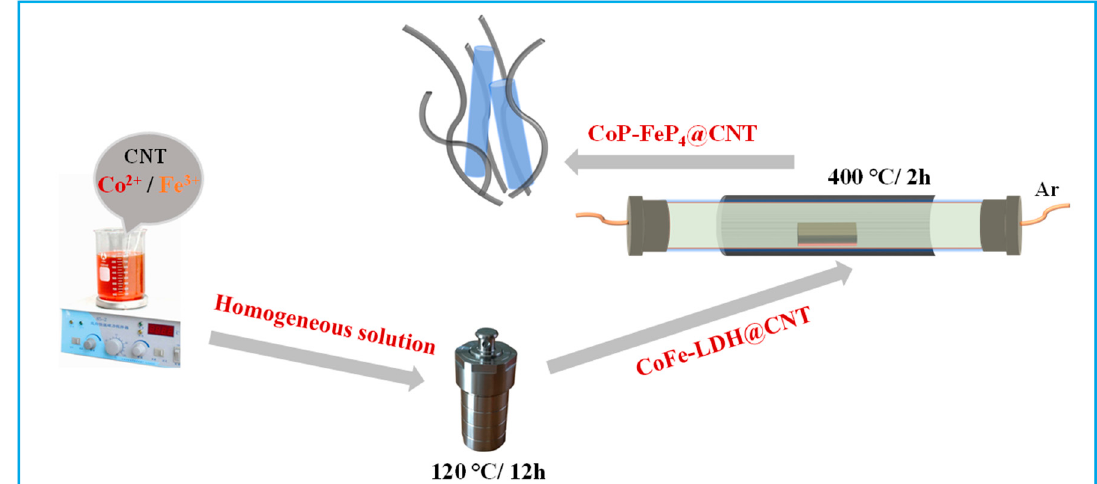
Figure 1. A two-step fabrication process of CoP/FeP 4 @CNT nanorods. The X-ray diffraction (XRD) pattern (Figure 2a) demonstrates that the characteristic peaks of CoP/FeP 4 @CNT match well with the standard patterns of CoP (PDF no. 29-0497) and FeP 4 (PDF no. 71-0473). Moreover, the peaks at 26.6 ◦ and 43.4 ◦ correspond to (111) and (010) of CNT (PDF No. 75-0473). The peaks at 32.6 ◦ , 36.7 ◦ and 52.2 ◦ are (131), (112), and (133) planes of FeP 4; the peaks at 31.9 ◦ , 36.7 ◦ , 46.5 ◦ , 48.4 ◦ , 52.2 ◦ and 56.7 ◦ correspond to (011), (102), (112), (202), (103), and (301) planes of CoP. In addition, as shown in Figure S1, the prominent peaks of the CoFe-LDH@CNT precursor correspond perfectly to FeO(OH) (PDF No. 34-1266) and CoOOH (PDF No. 26-0480). The Raman spectrum shows